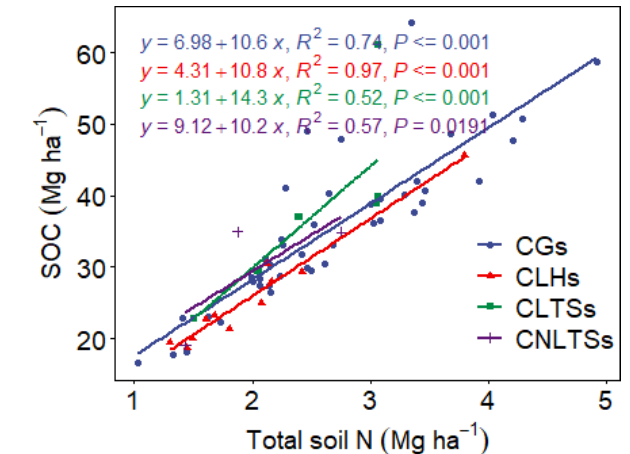
Figure 5. Relationships between SOC and soil total N as influenced by plant functional groups. CLTSs – cut–use legume trees/shrubs; CGs – cut–use grasses; CNLTSs – cut–use non-legume trees/shrubs; CLHs – cut–use legume herbs.